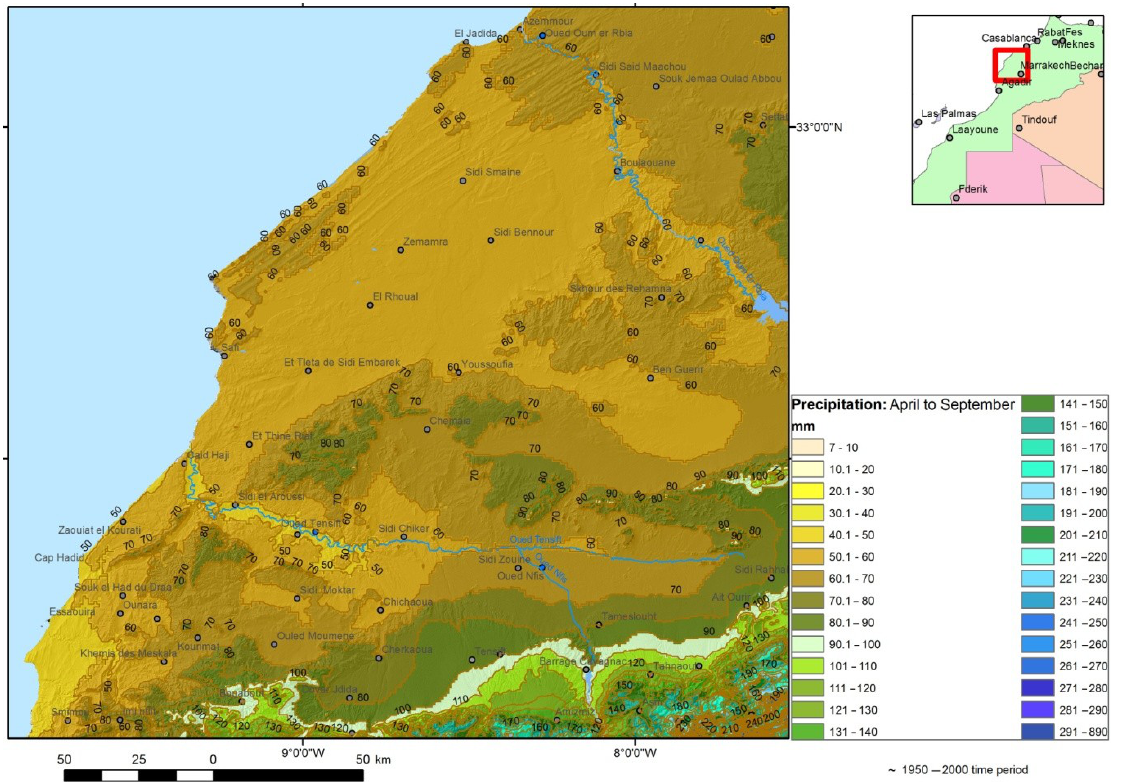
Figure 3. Mean precipitation (mm) during April–September.